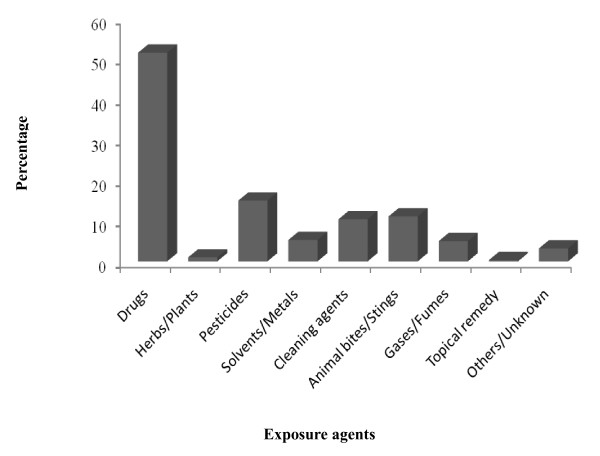
Categories of exposure agent.